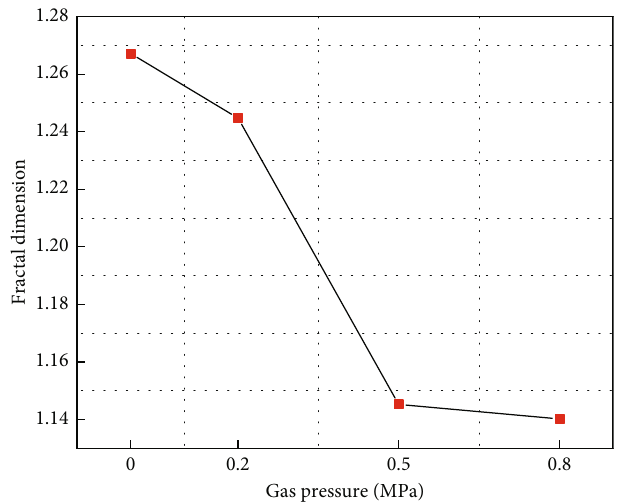
Figure 7: The simple fractal dimension